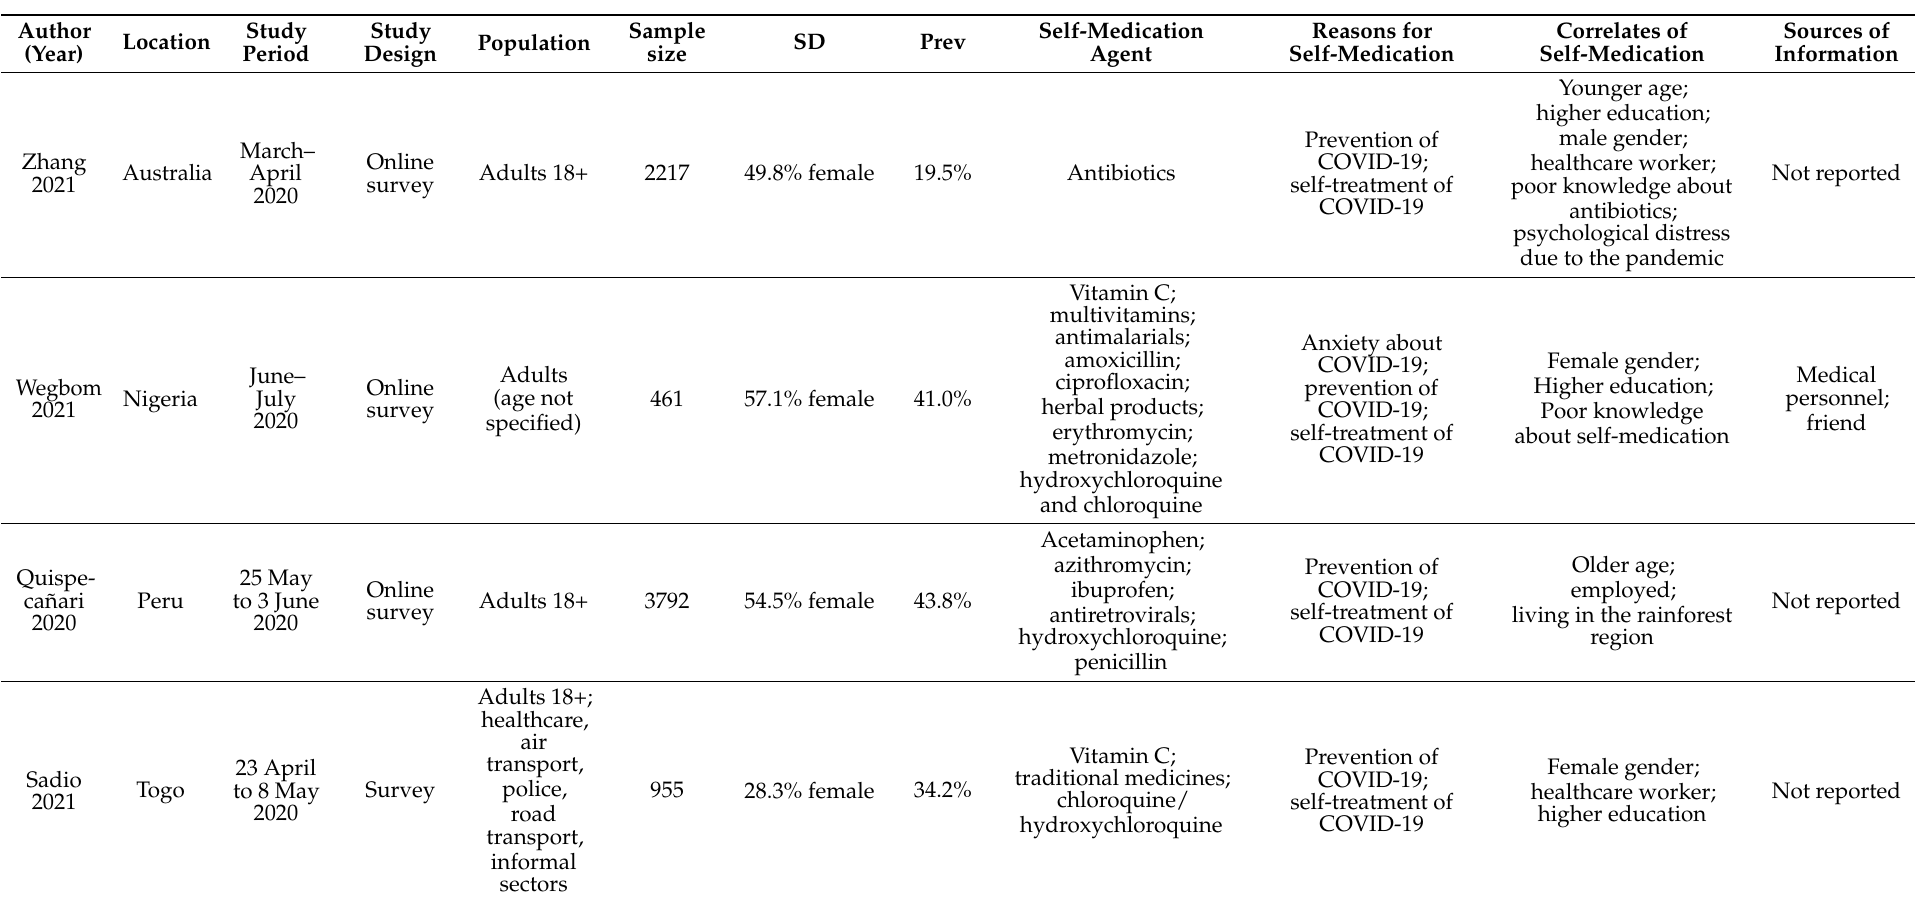
Table 2. Characteristics of the included